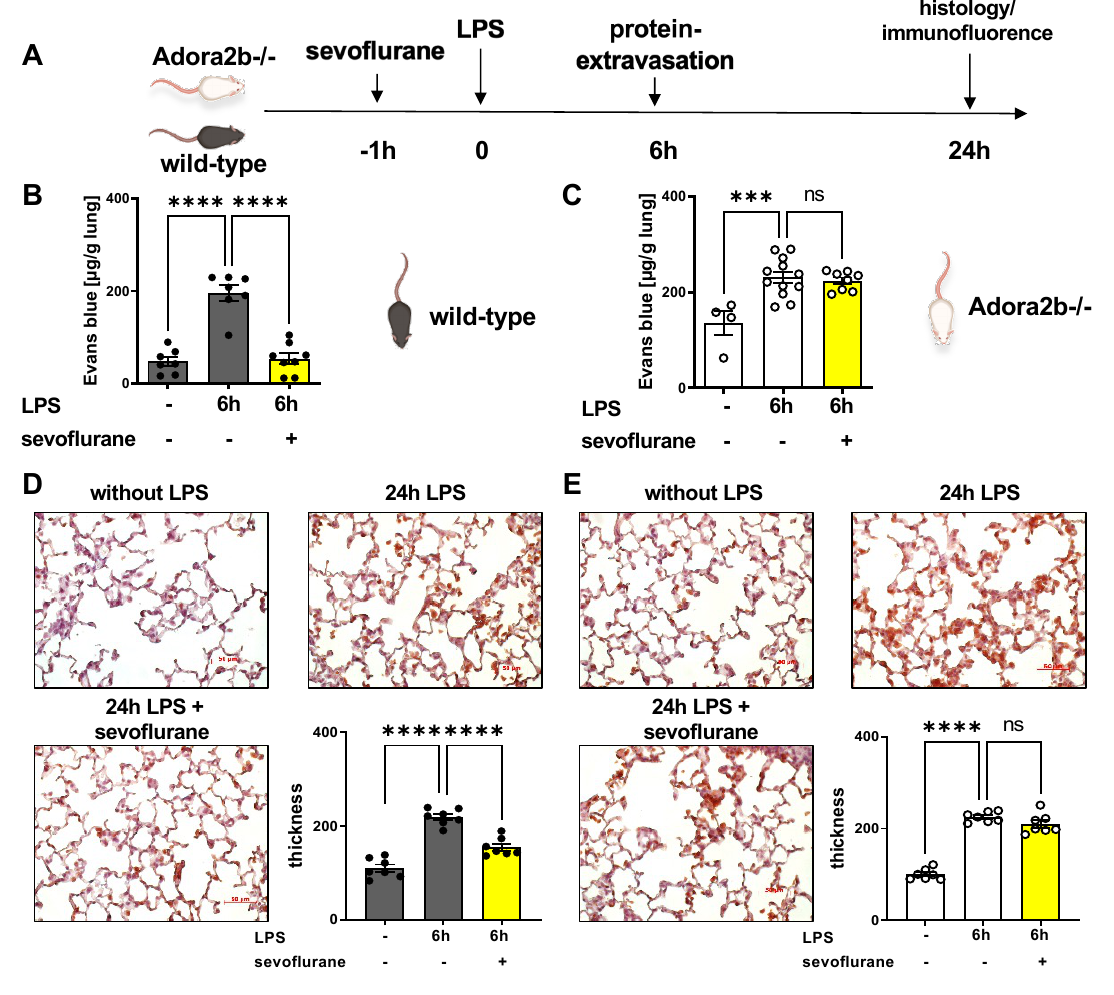
wild-type Figure 4. Cont